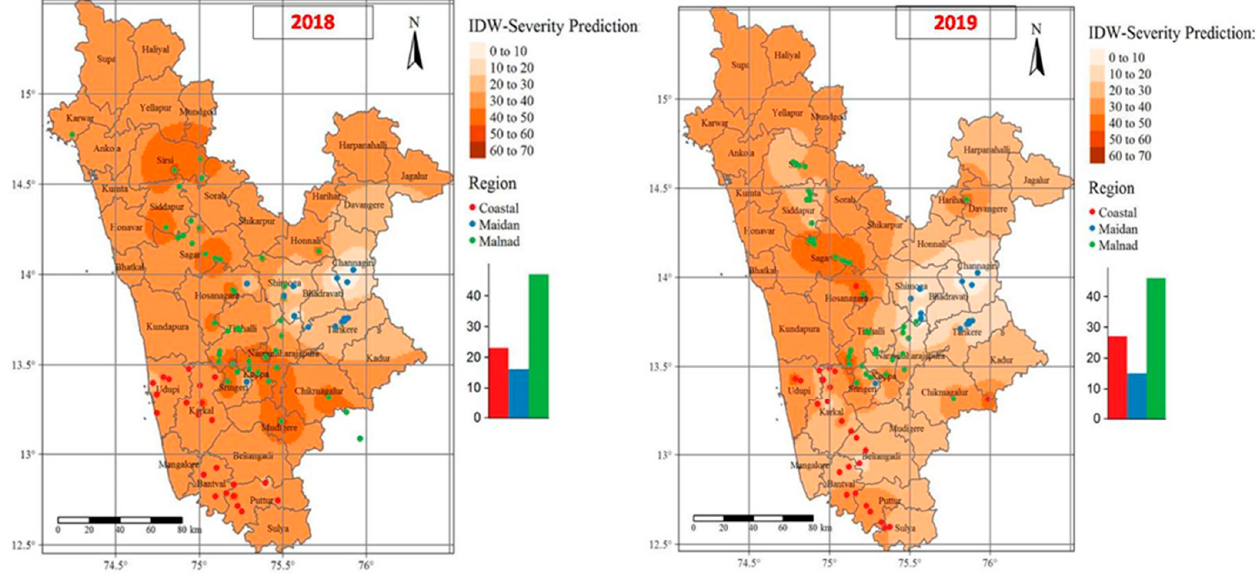
Figure 5. The optimized interpolated disease severity maps of FRD were generated using the inverse distance weighted (IDW) deterministic tool. Darker to lighter colors indicate higher to lower disease severity.